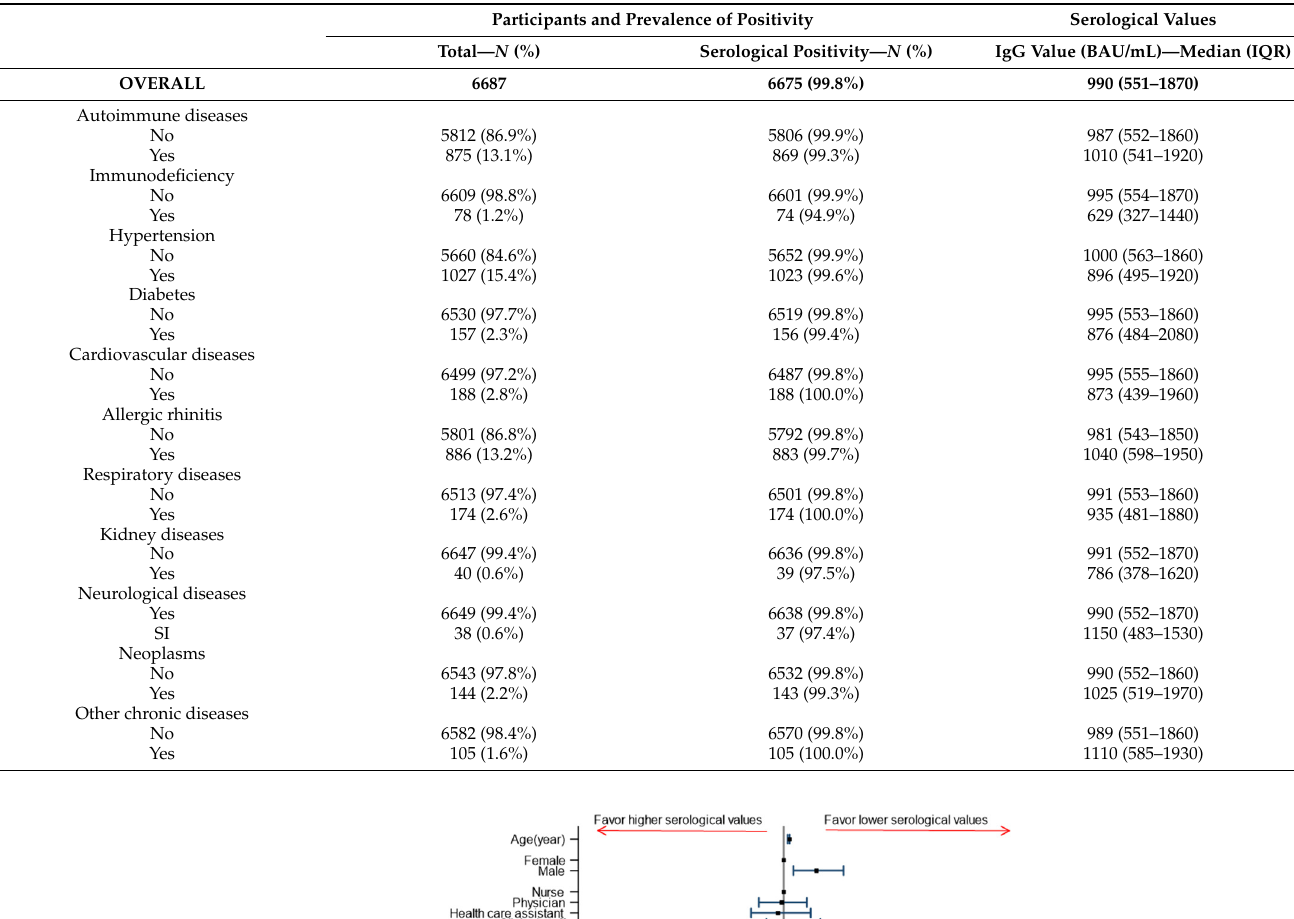
Table 3. Participants (first column), prevalence of seropositivity (second column), and serological values (third column) among 6687 vaccinated HCW of CSS participating in the serological post- vaccination survey on May 2021, by self-reported diseases/disorders.